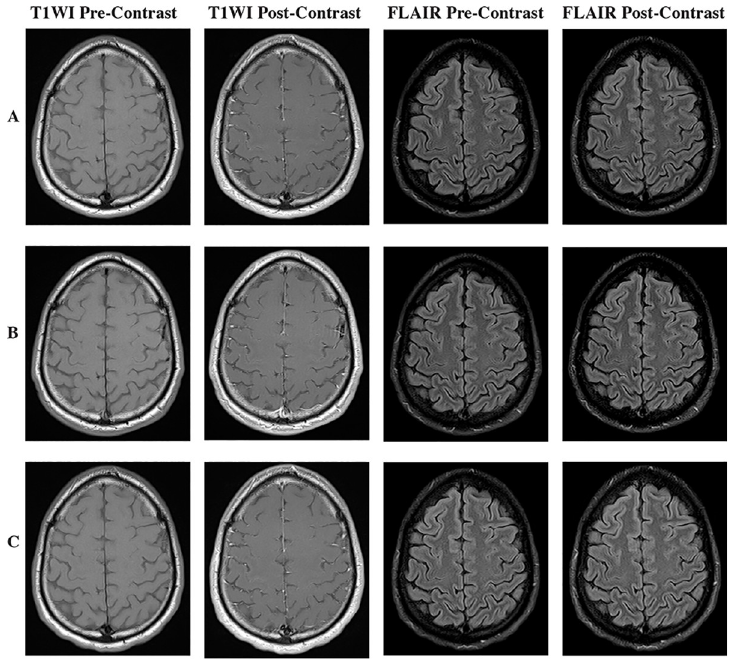
Fig 4. Imaging from the only subject scored positive for traumatic meningeal enhancement on T1WI post- contrast, but negative on FLAIR post-contrast. Pre-contrast T1WI and FLAIR images are shown for comparison. (A) According to raters this patient was scored positive due to the visualized pattern of contrast which seemed to thicken in the falx cerebri on the acute post-injury T1WI post-contrast sequences, while showing no findings on FLAIR post- contrast. (B) One week post-injury MRI shows a similar pattern of enhancement in falx cerebri-of T1WI post-contrast and a consistent lack of enhancement on FLAIR post-contrast. (C) T1WI and FLAIR post-contrast sequences one year post injury show once again a similar pattern of contrast on T1WI post-contrast sequence with no associated findings on FLAIR post-contrast sequence.